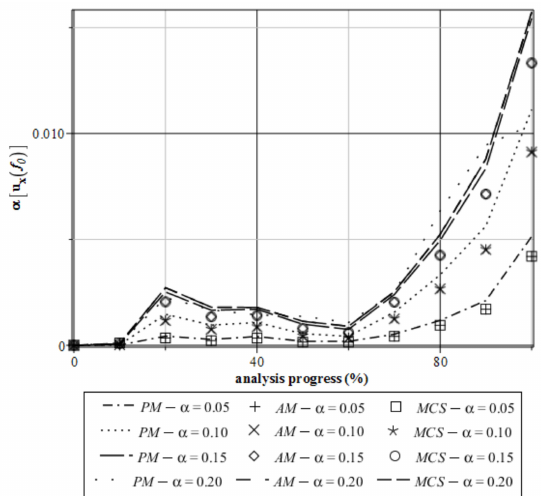
Figure 8. Coefficient of variation of the extreme horizontal displacements α [u x (f 0 )] for the specimen.